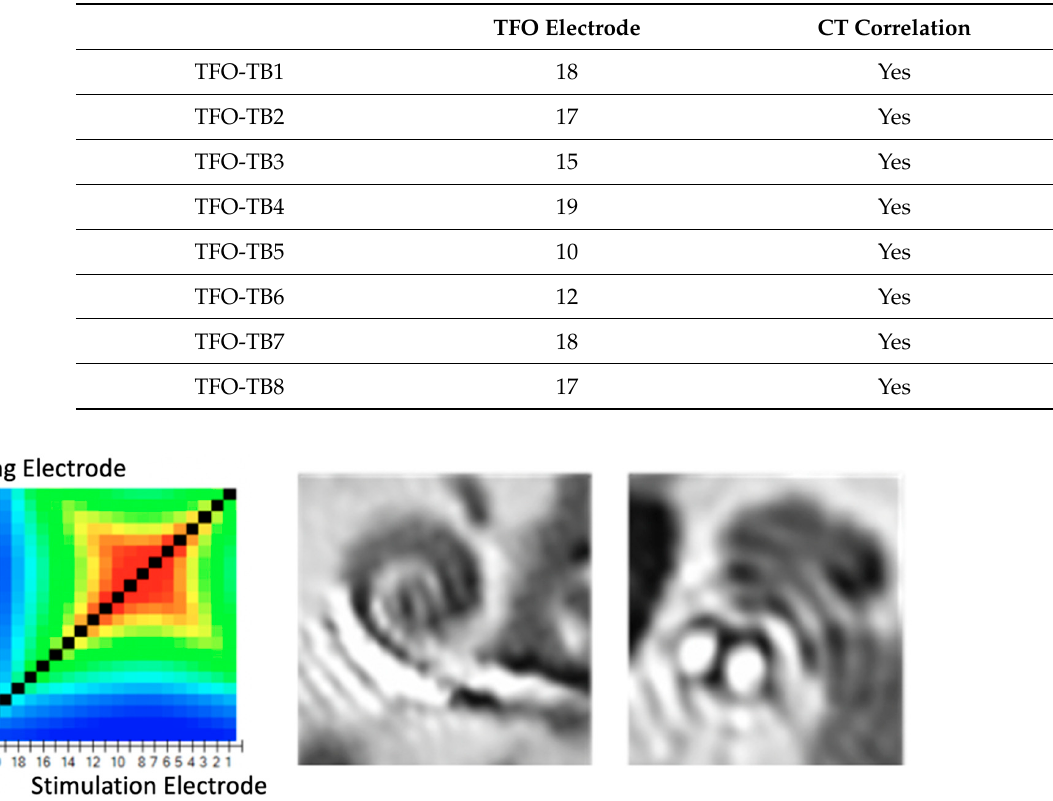
Figure 6. Correlation of TIM patterns with CT imaging shows instances whereby the electrode had folded overs.